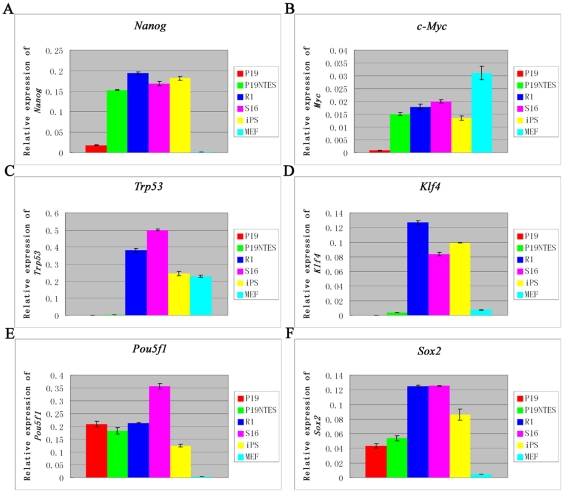
The comparison of P19 NTES cells to normal ES cells, NTES cells, iPS cells and MEF.Quantitative PCR was used to assess the difference among these cells at the level of mRNA by analyzing several important genes. (A), (B) Nanog and c-Myc are representative of genes that could be induced in P19 NTES cells successfully. (C), (D) Trp53 and Klf4 are representative of genes that could not be induced in P19 NTES cells. (E), (F) Pou5f1 and Sox2 are genes that did not change during the process of EC reprogramming. Error bars depict standard deviation. p-value<0.01.